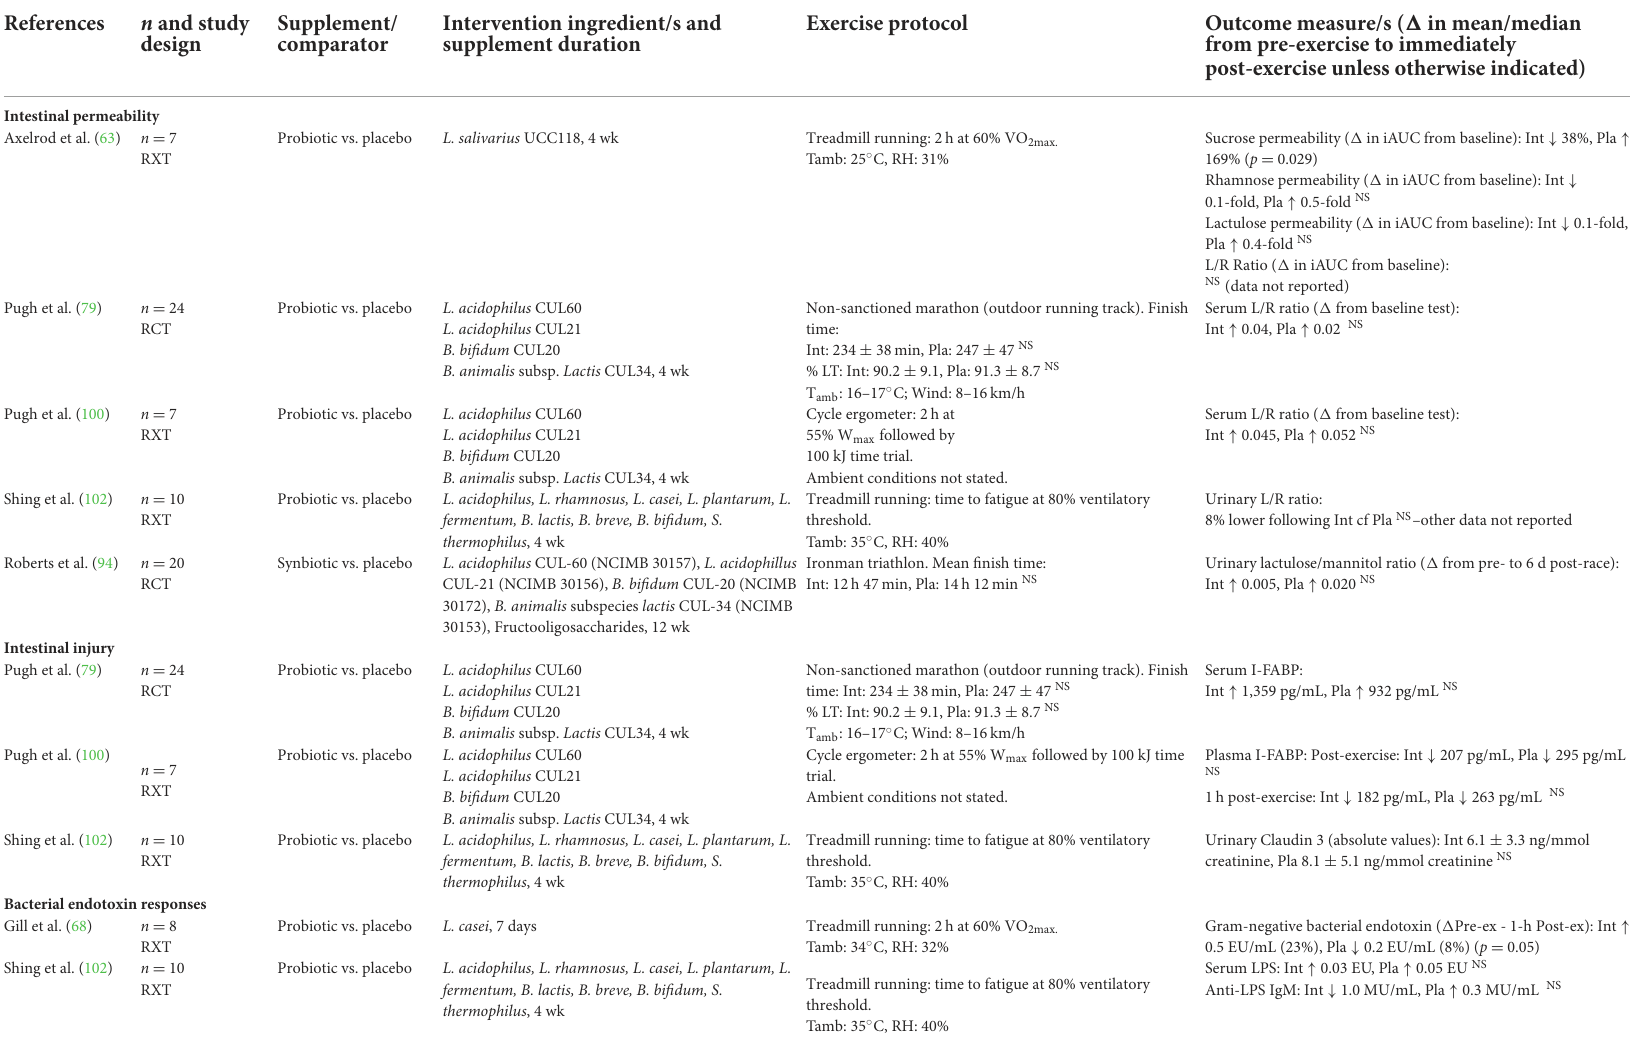
TABLE 6 Systematic review study outcomes for included studies that investigated the impact of prebiotic, probiotic and synbiotic supplementation on markers of EIGS in response to an acute exercise